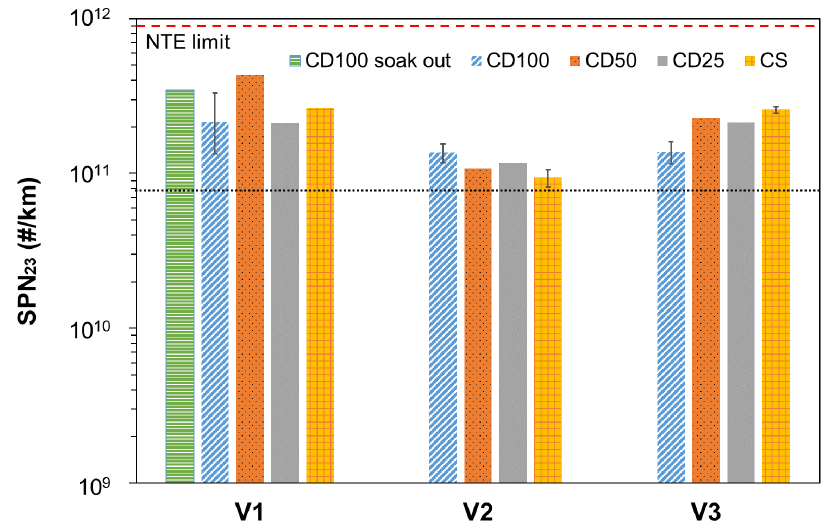
Figure 3. Solid particle number emissions (>23 nm) (SPN 23 ) of three plug-in hybrid electric vehicles (V1 to V3) during on-road tests performed according to the European real driving emissions regulation (RDE4). CDx denotes the charge of the REESS; CD100 for 100%, CD50 for 50%, CD25 for 25%. CS stands for trips in charge-sustaining or discharged REESS. The error bars show the maximum and minimum values for tests with more than one repetition. The red dashed line shows the Euro 6 on-road not-to-exceed (NTE) limit (9 × 10 11 #/km) and the black dotted line shows the average on-road SPN 23 emissions of eight conventional Euro 6d/6d-TEMP gasoline direct injection vehicles [34].